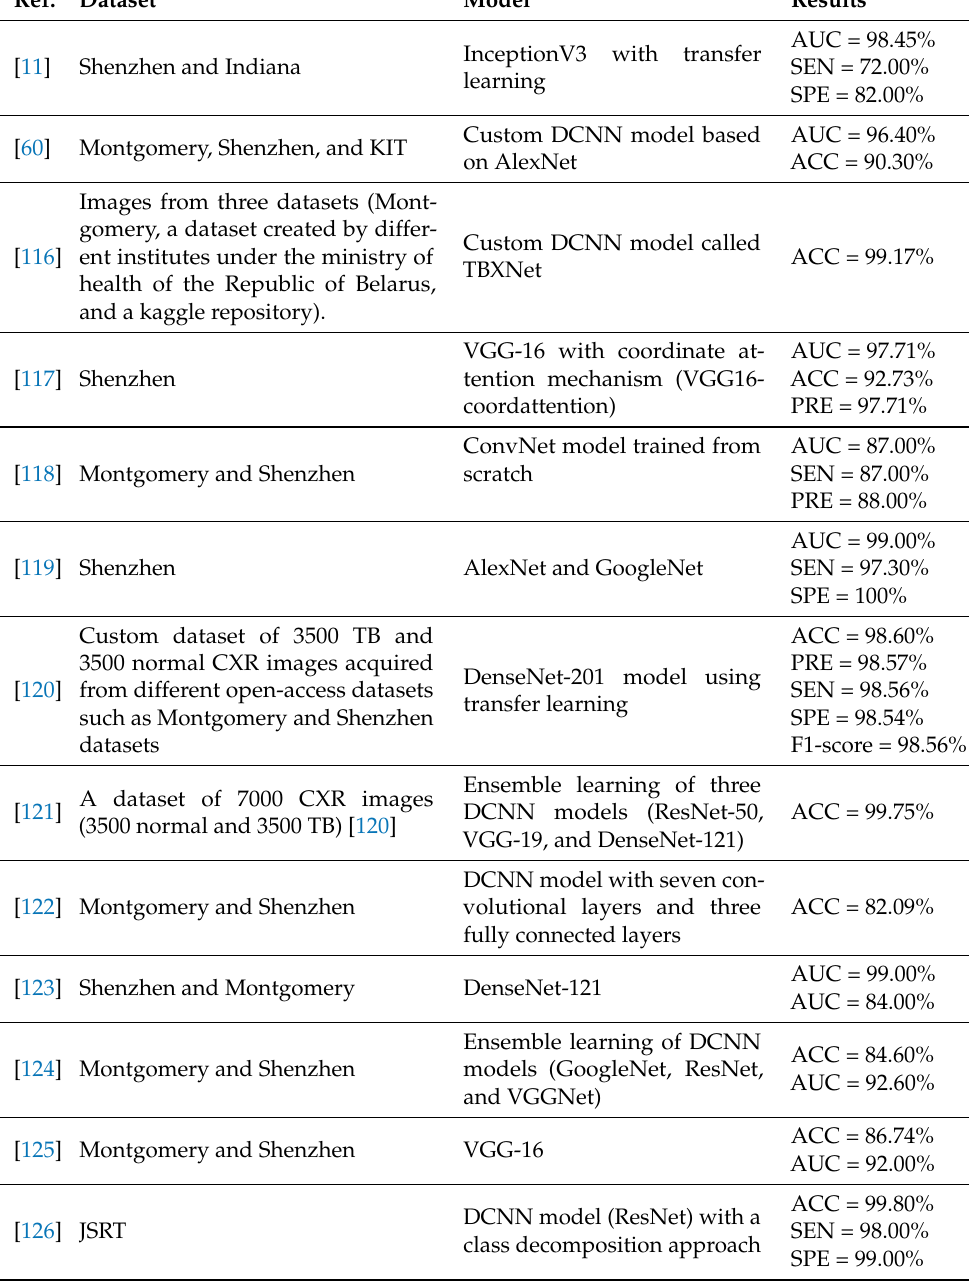
Table 9. Summary of different DL architectures used for tuberculosis